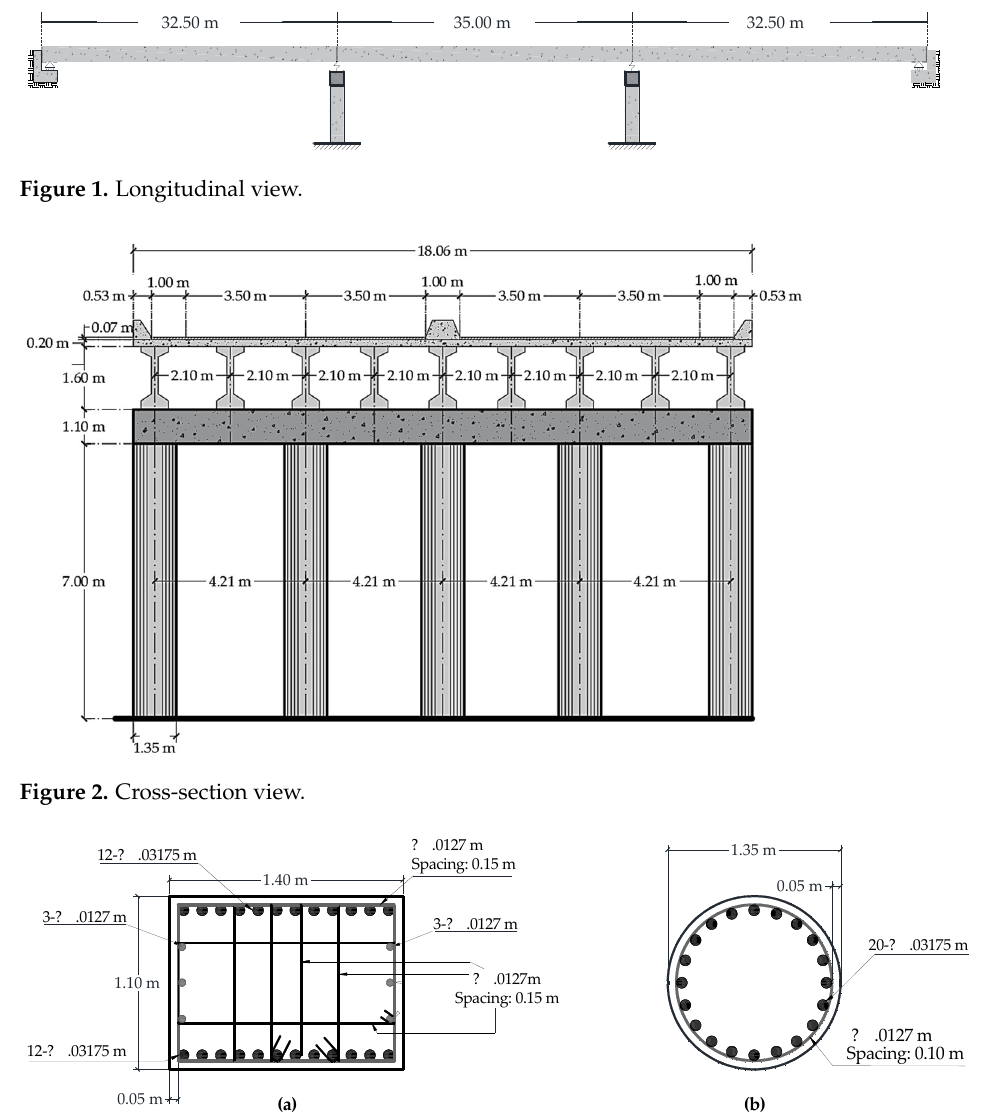
Figure 3. Geometry and design: ( a ) cap beams and ( b ) columns.